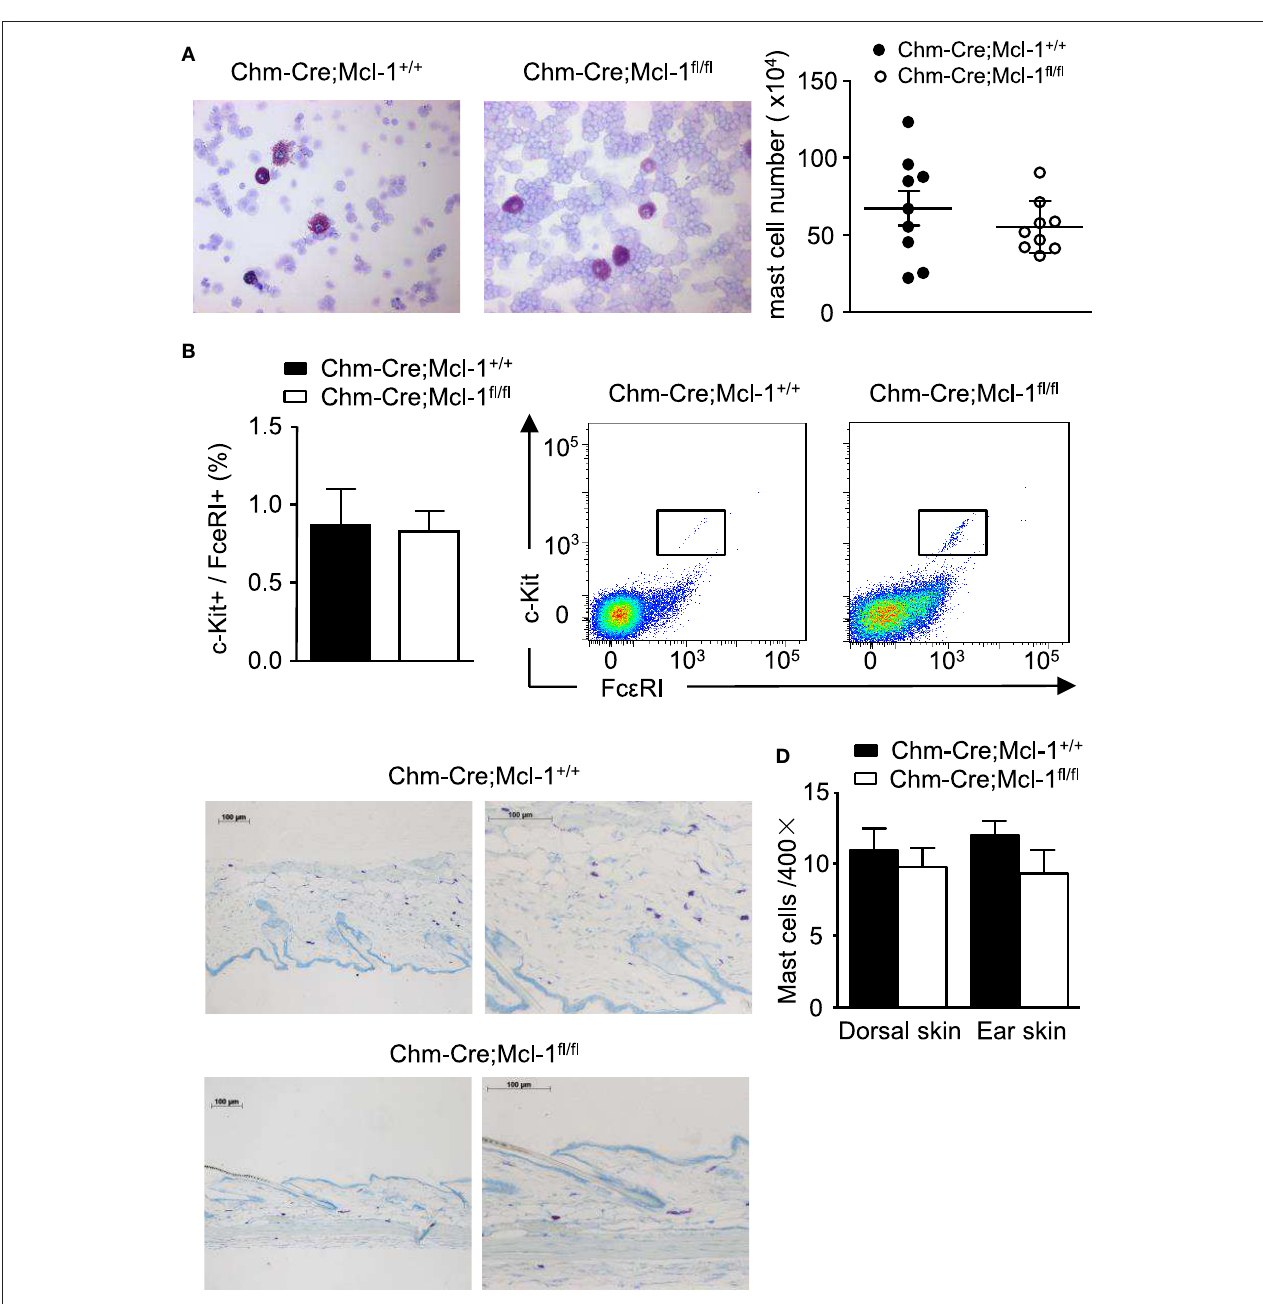
FIGURE 4 | Chm-Cre; Mcl-1 fl / fl mice exhibit no variation of cell number in representative sites of connective tissue mast cell (CTMC) populations as compared to Chm-Cre; Mcl-1 + / + mice. (A) Cytospins of peritoneal lavage fluid from Chm-Cre; Mcl-1 + / + mice and Chm-Cre; Mcl-1 fl / fl mice were stained with Giemsa solution and MC numbers were assessed by Neubauer Hemocytometry. Mice exhibit comparable numbers of PMCs (right) with similar morphological features. (B) Percentage of mast cell surface markers expression (left) and representative flow cytometry plots (right) showed comparable expression of c-kit and Fc ε RI on PMCs isolated from Chm-Cre; Mcl-1 + / + mice and Chm-Cre; Mcl-1 fl / fl mice. (C) Giemsa staining of 5- µ m-thick paraffin sections of dorsal skin obtained from Chm-Cre; Mcl-1 + / + and Chm-Cre; Mcl-1 fl / fl mice show comparable numbers of MCs (purple). (D) MCs in dorsal and ear skin tissues show similar amounts of dermal MCs. (A) 400 × magnification, (C) left: 100 × magnification, (C) right: 200 × magnification. Data were pooled from two ( A,B ; n = 3 mice per group ± SEM) or five independent experiment ( C,D ; n = 5 mice per group ±